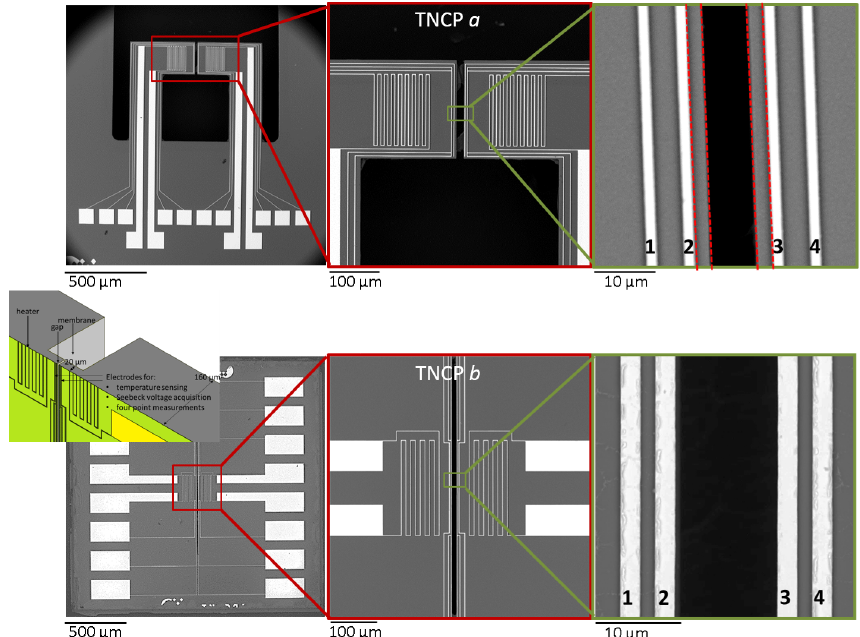
Figure 1. Two measurement platforms. Top: TNCP a , cantilever-based design; bottom: TNCP b , membrane-based design. The schematic inset illustrates Platform b ’s cross-section to show its layout. In both cases, the electrodes are made of Pt.